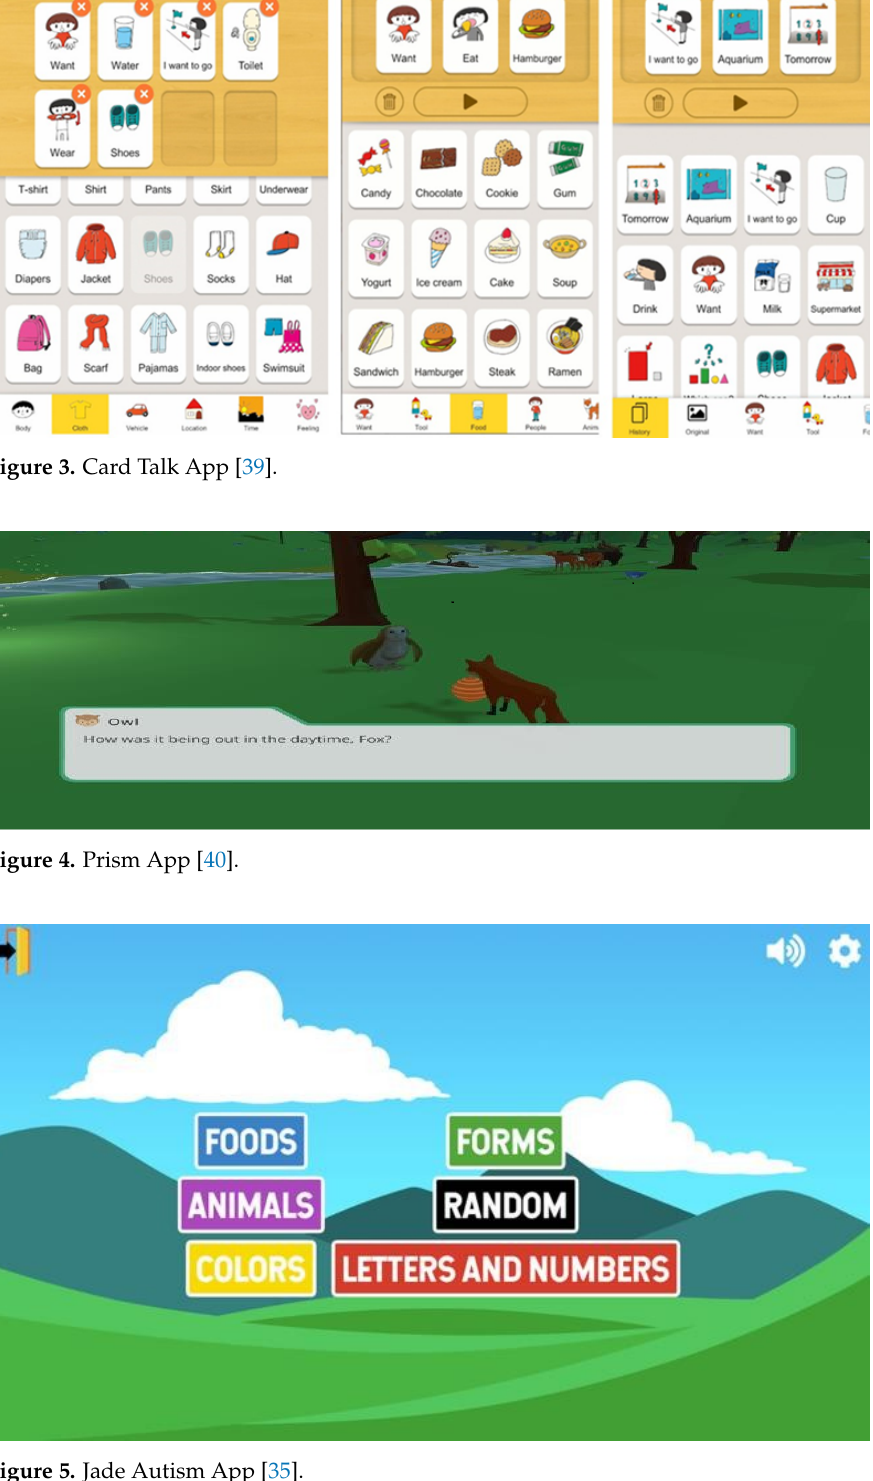
Figure 5. Jade Autism App